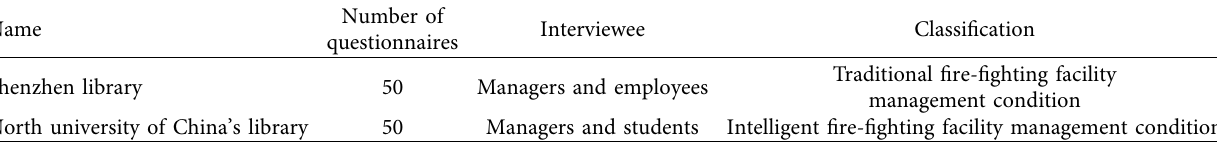
Table 2: Case study form.